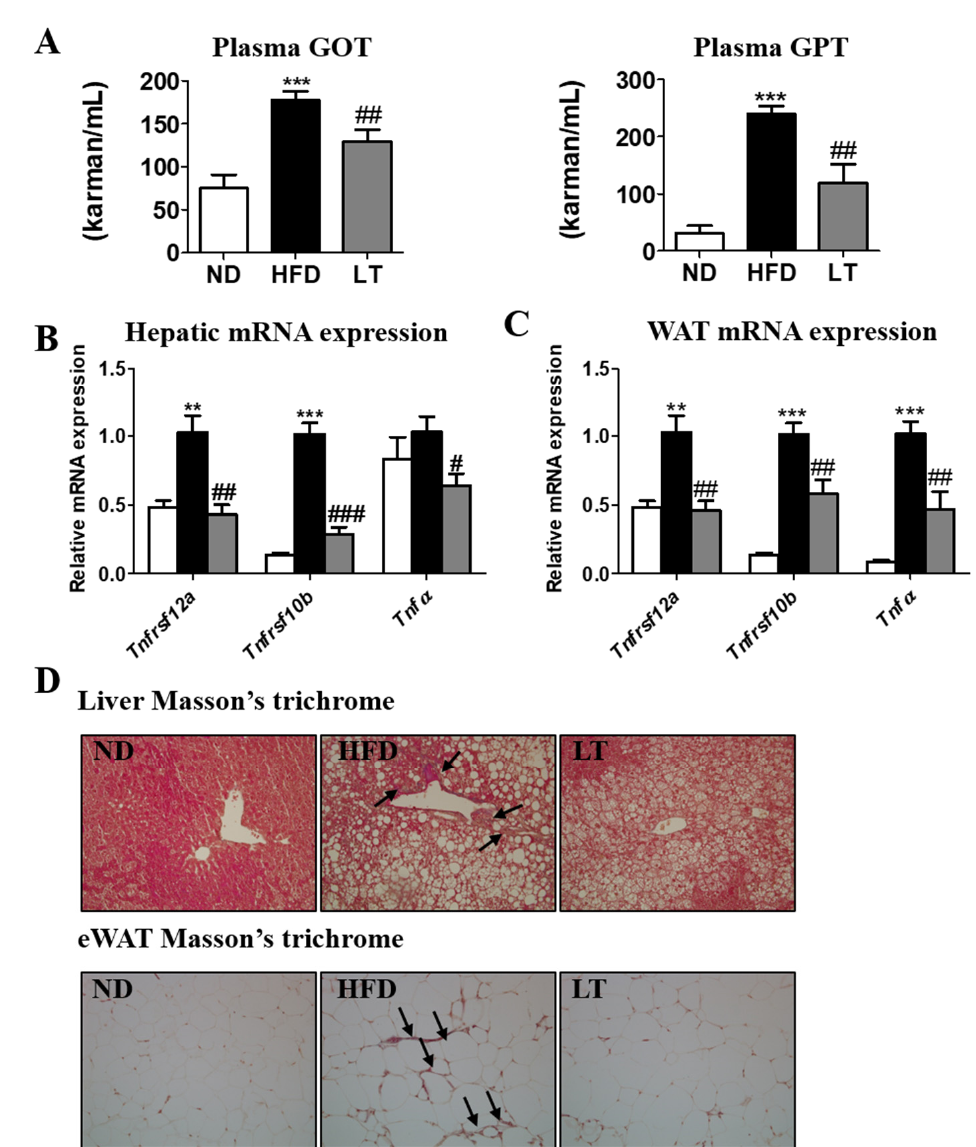
Figure 5. Effect of LT water extract supplement in diet-induced obesity on plasma GOT and GPT ( A ), hepatic mRNA expression ( B ), epididymal adipose tissue mRNA expression ( C ), and Masson’s trichrome stained transverse-section of liver and epididymal fat (200× magnification) ( D ) in C57BL/6J mice fed a high-fat diet; Data are the mean ± SE. Significant differences between HFD versus ND are indicated: ** p < 0.01, *** p < 0.001. Significant differences between HFD versus LT are indicated: # p < 0.05, ## p < 0.01, ### p < 0.001. ND, normal diet (AIN-93G); HFD, high-fat diet (60% kcal from fat); LT, HFD + Lycopus lucidus Turcz water extract (1.5%, w / w ). GOT, glutamic oxaloacetic transaminase; GPT, glutamic pyruvic transaminase; tnfrsf, tumor necrosis factor receptor superfamily member; tnf α , tumor necrosis factor- α